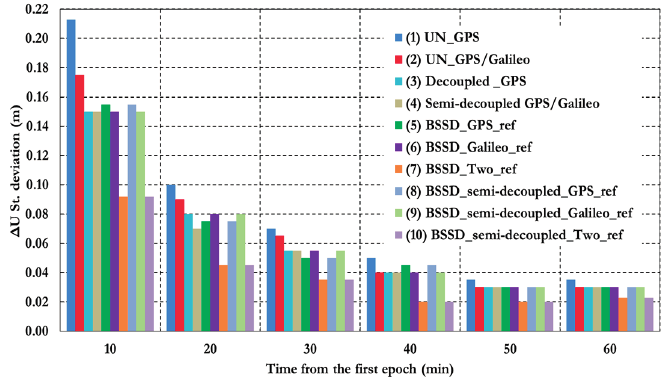
Figure 25. Summary of positioning standard deviations in East, North, and Up directions of all stations and analysis cases. ( 1 ) Un-differenced GPS model; ( 2 ) Un-differenced GPS/Galileo model; ( 3 ) Decoupled clock model using GPS observations only; ( 4 ) semi-decoupled clock GPS/Galileo PPP model; ( 5 ) BSSD model with a GPS satellite as a reference; ( 6 ) BSSD model with a Galileo satellite as a reference; ( 7 ) BSSD model with both a GPS and a Galileo satellite as reference satellites; ( 8 ) BSSD semi-decoupled clock GPS/Galileo model with a GPS satellite as a reference; ( 9 ) BSSD semi-decoupled clock GPS/Galileo model with a Galileo satellite as a reference; ( 10 ) BSSD semi-decoupled clock GPS/Galileo model with both a GPS and a Galileo satellite as reference